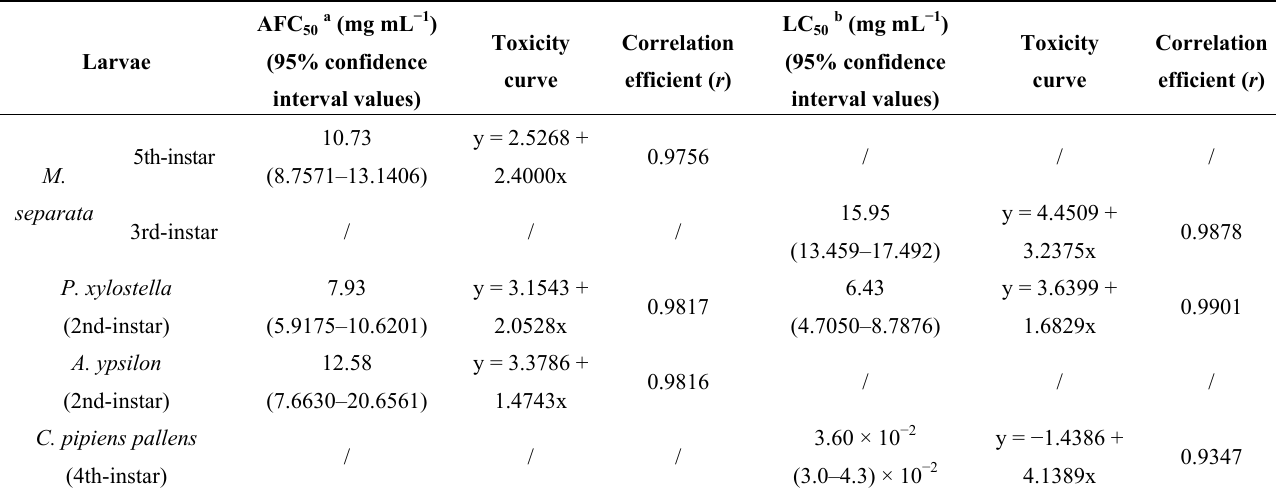
Table 1. Feeding deterrent and toxic effects of fraxinellone against different